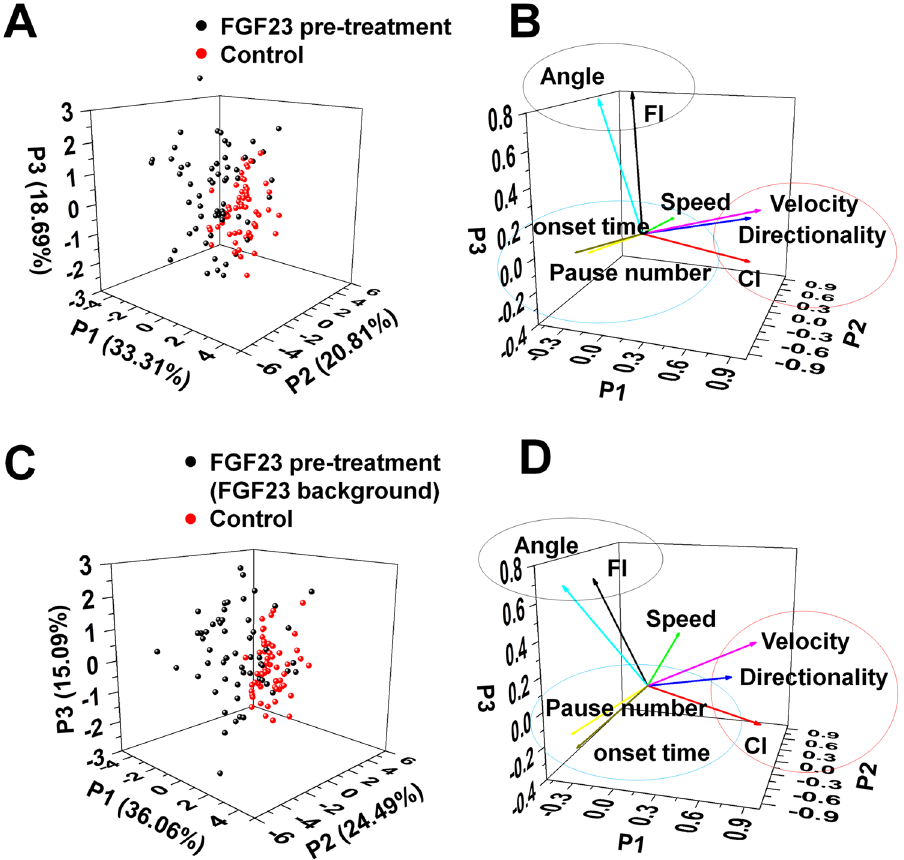
Figure 6. Principle component analysis to compare cell migration with or without FGF23 treatment. ( A ) Score plot of FGF23 pre-treated cells (black dots) and un-treated control cells (red dots) in a 100 nM f MLP gradient in the 3D transformed domain of the first three principle component axes (P1, P2, P3). The percentage of variation accounted by each principle axis is labeled; ( B ) Correlation vector plot of cell migration parameters in the 3D transformed domain of the first three principle component axes (P1, P2, P3) for the experiments in ( A ). The vector indicates the correlation of each cell migration parameter to the first three principle component axes. Significantly correlated parameters are circled; ( C ) Score plot of FGF23 pre-treated cells and control cells in a f MLP gradient with a uniform FGF23 background in the 3D transformed domain of the first three principle component axes (P1, P2, P3). The percentage of variation accounted by each principle axis is labeled; ( D ) Correlation vector plot of cell migration parameters in the 3D transformed domain of the first three principle component axes (P1, P2, P3) for the experiments in ( C ). The vector indicates the correlation of each cell migration parameter to the first three principle component axes. Significantly correlated parameters are circled. The data shown are from representative experiments using the C 3